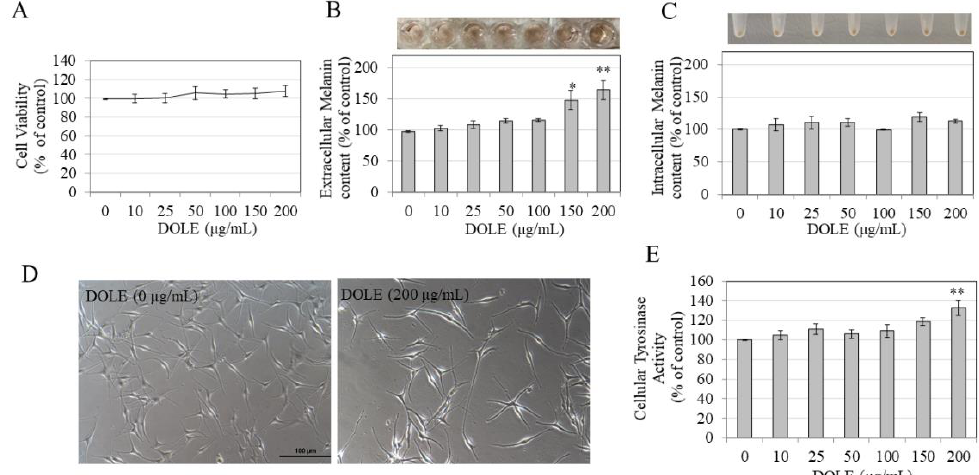
Figure 3. ( A ) HEMn-LP cell viability in the presence of different concentrations of DOLE; ( B ) extracellular melanin levels and ( C ) intracellular melanin levels in cultures of HEMn-LP treated for 48 h with different concentrations of DOLE; ( D ) representative phase-contrast micrographs showing cells treated without and with DOLE (200 µ g/mL); ( E ) cellular tyrosinase activity in HEMn-LP cells after treatment with DOLE for 48 h. * p < 0.05 vs. control; ** p < 0.01 vs. control; one-way ANOVA with Dunnett’s post hoc test. Data for ( B ) and ( C ) are mean ± SEM of two independent experiments, while all other data are mean ± SEM of at least three independent experiments. Table 1. Dendricity parameters in HEMn-LP cells after treatment with DOLE at 200 µ g/mL for 48 h.